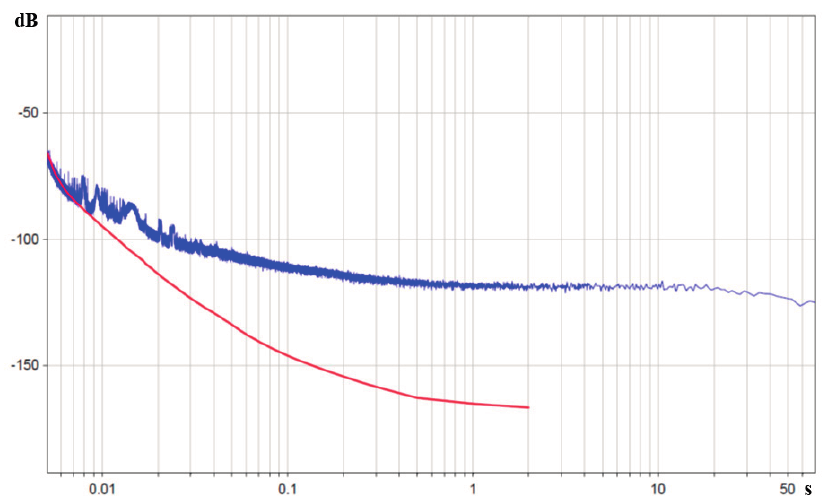
Figure 10. Power spectral density of molecular electronic sensor noise in units of input angular acceleration in decibels relative to 1 rad/s 2 / √Hz is the blue curve, whereas noise of operational amplifier AD706 with input sensor impedance is the red curve. The X-axis is the periods in seconds.